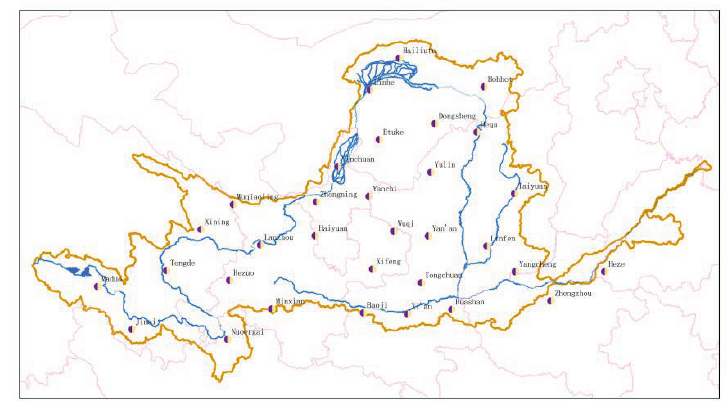
Fig. 1 Location of the meteorological stations in the Yellow River